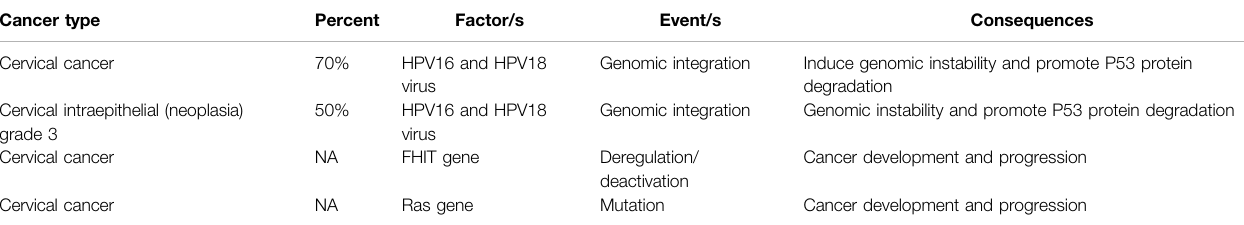
TABLE. 2 | Some factors involved in different type of cervical